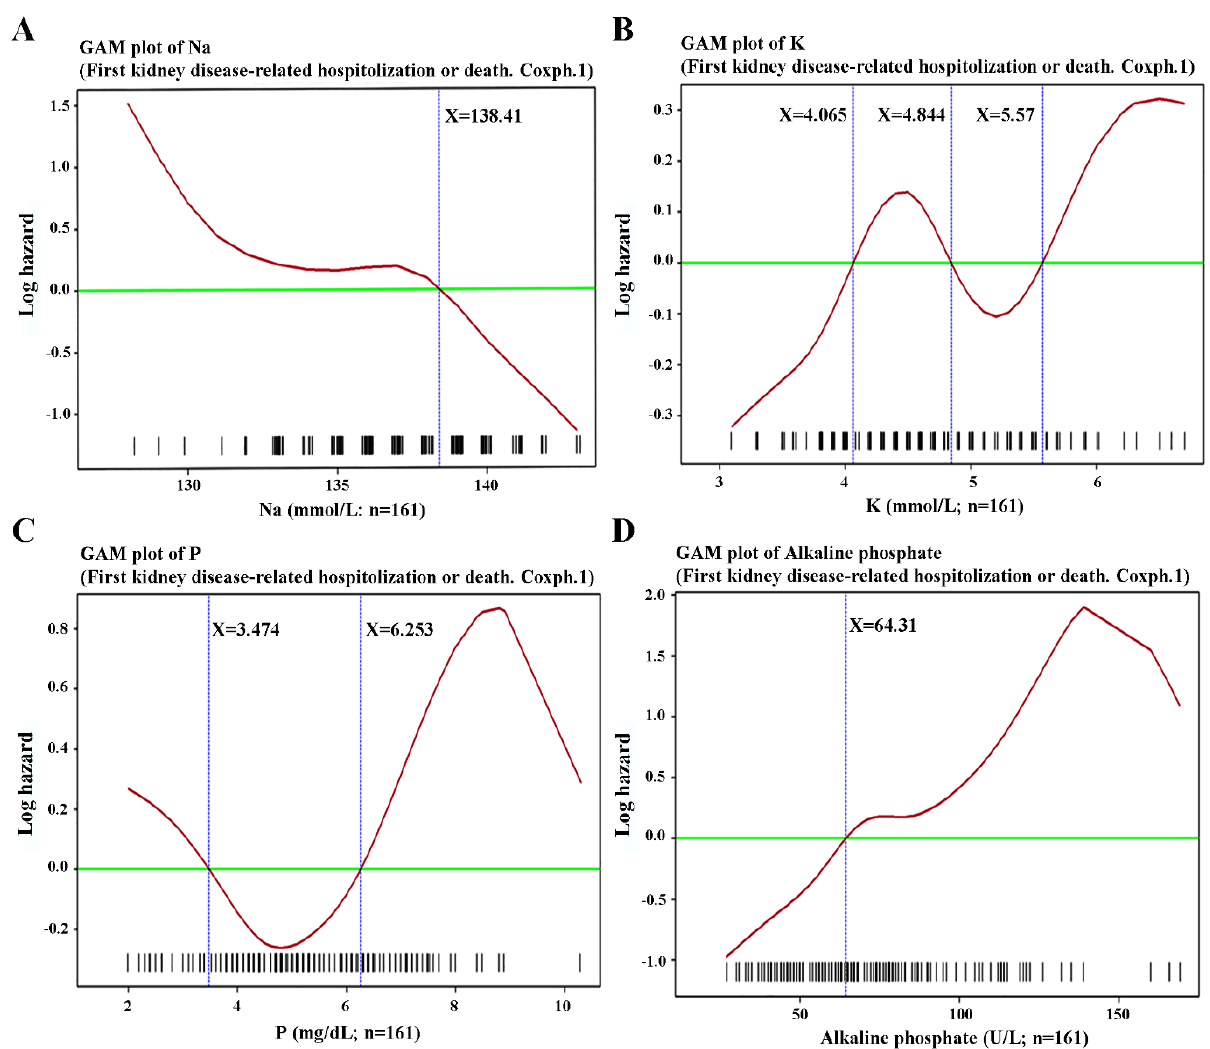
Figure 5. Generalized additive model (GAM) plots of time to first kidney disease-related hospital- ization or death versus ( A ) sodium (Na; mmol/L), ( B ) potassium (K; mmol/L), ( C ) phosphate (P; mg/dL), and ( D ) alkaline phosphate (U/L).